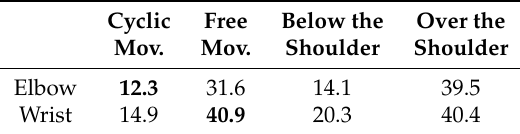
Table 8. Fusion RMSE for position estimation (mm). Cyclic